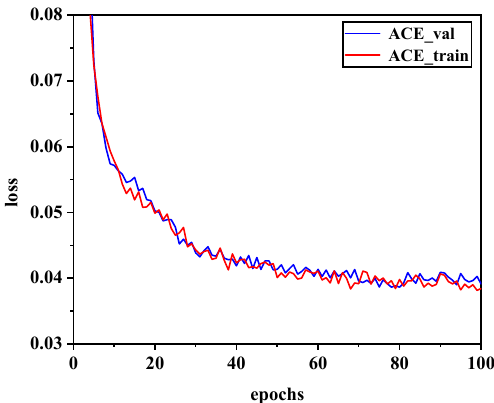
Figure 11. The loss curve of the first-level network in the training process of the original data and the data processed by the ACE method.